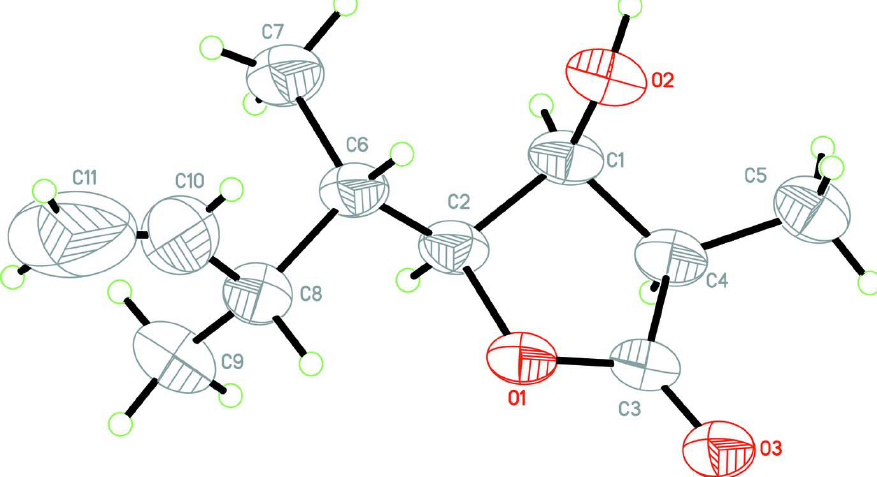
Figure 1 The molecular structure of molecule one of (I), with displacement ellipsoids for the non-hydrogen atoms shown at the 30% probability level.